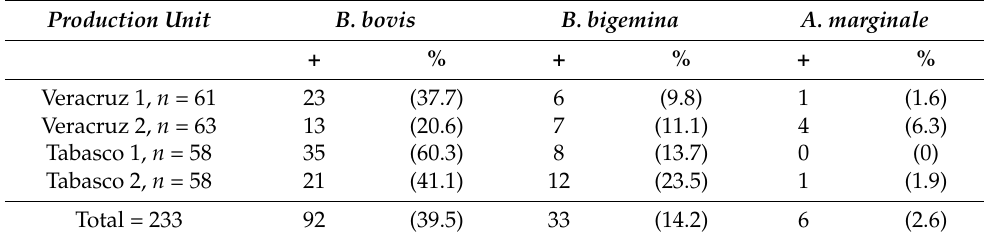
Table 2. nPCR detection of B. bovis , B. bigemina , and A. marginale in water buffaloes from Mexico. Production Unit